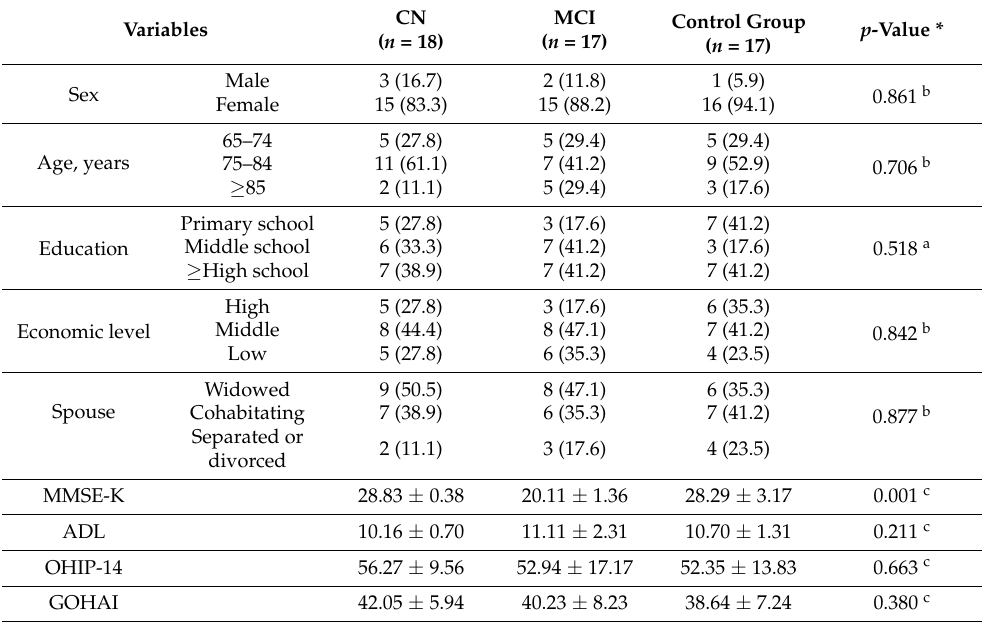
Table 1. General characteristics of the participants.